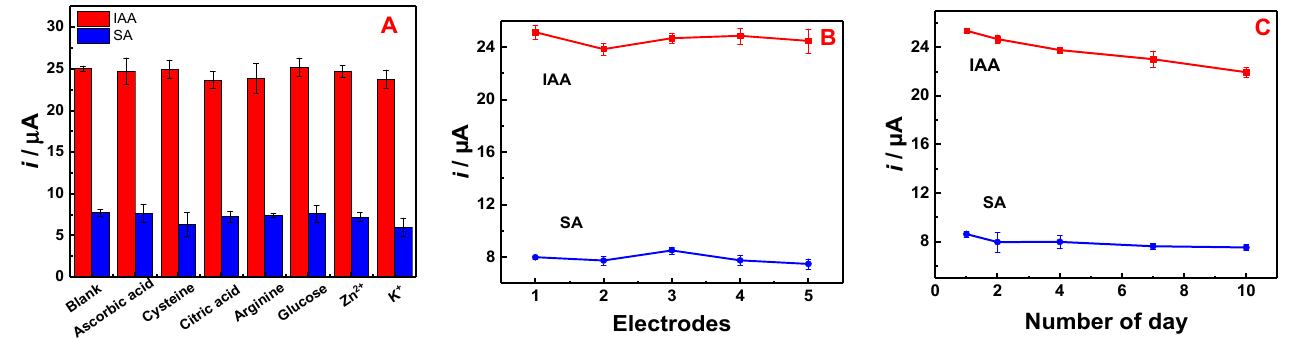
Figure 11. ( A ) LSV anodic current responses of CuNPs-CSF-CNPs-MWCNTs/GCE in 0.1 M PBS (pH = 7) containing 50 µ M IAA and 50 µ M SA in the presence of different interfering substances, respectively. ( B ) LSV anodic current response of five CuNPs-CSF-CNPs-MWCNTs/GCE electrodes in 0.1 M PBS (pH = 7) containing 50 µ M IAA and 50 µ M SA. ( C ) LSV anodic current responses of